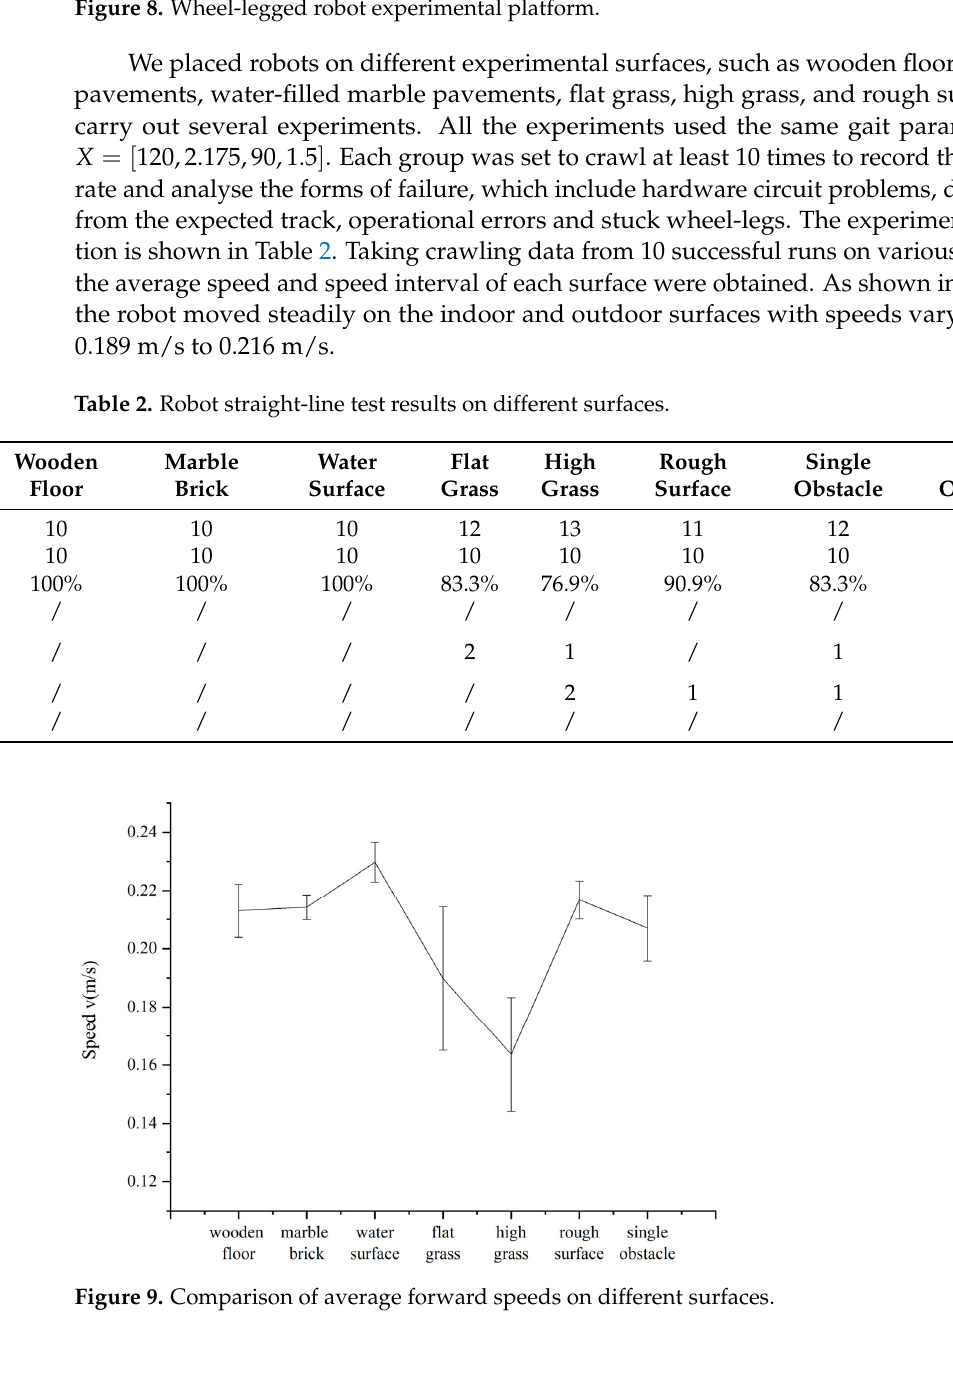
Figure 8. Wheel-legged robot experimental platform.